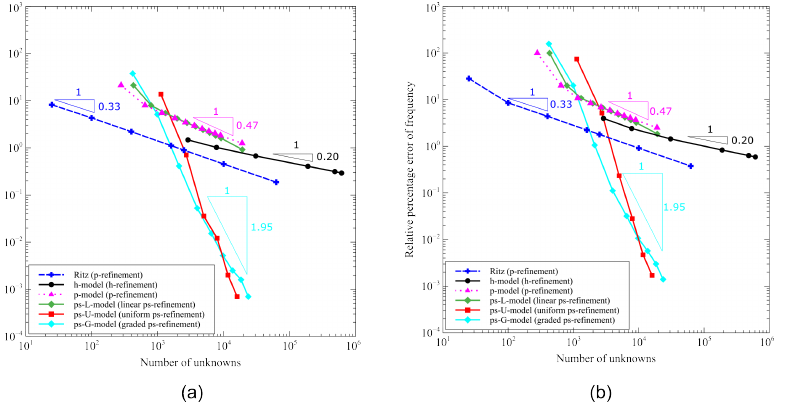
Figure 18. Highly anisotropic plate: convergence for different refinement strategies: ( a ) nondimen- sional fundamental frequency and ( b ) nondimensional buckling